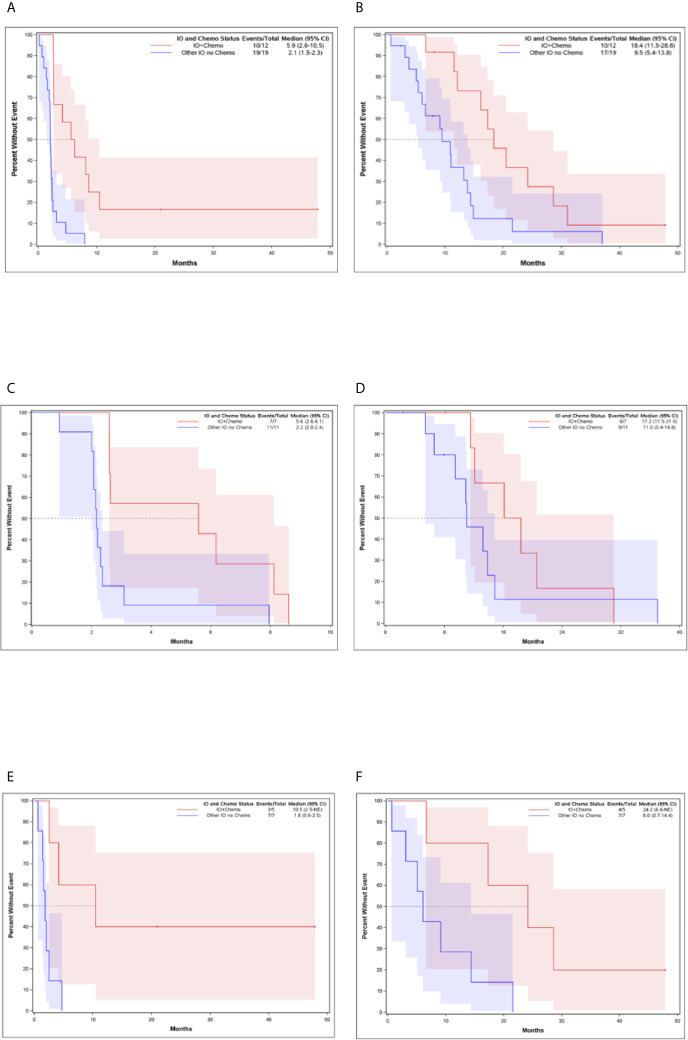
Kaplan-Meier Curves for Patients Who Received IO and Chemotherapy Compared to Patients Who Received IO Without Chemotherapy (A) Progression-Free Survival for all patients (B) Overall Survival for all patients (C) Progression-Free Survival for HR-positive, HER-2 negative breast cancer (D) Overall Survival for HR-positive, HER-2 negative breast cancer (E) Progression-Free Survival for TNBC (F) Overall Survival for TNBC.